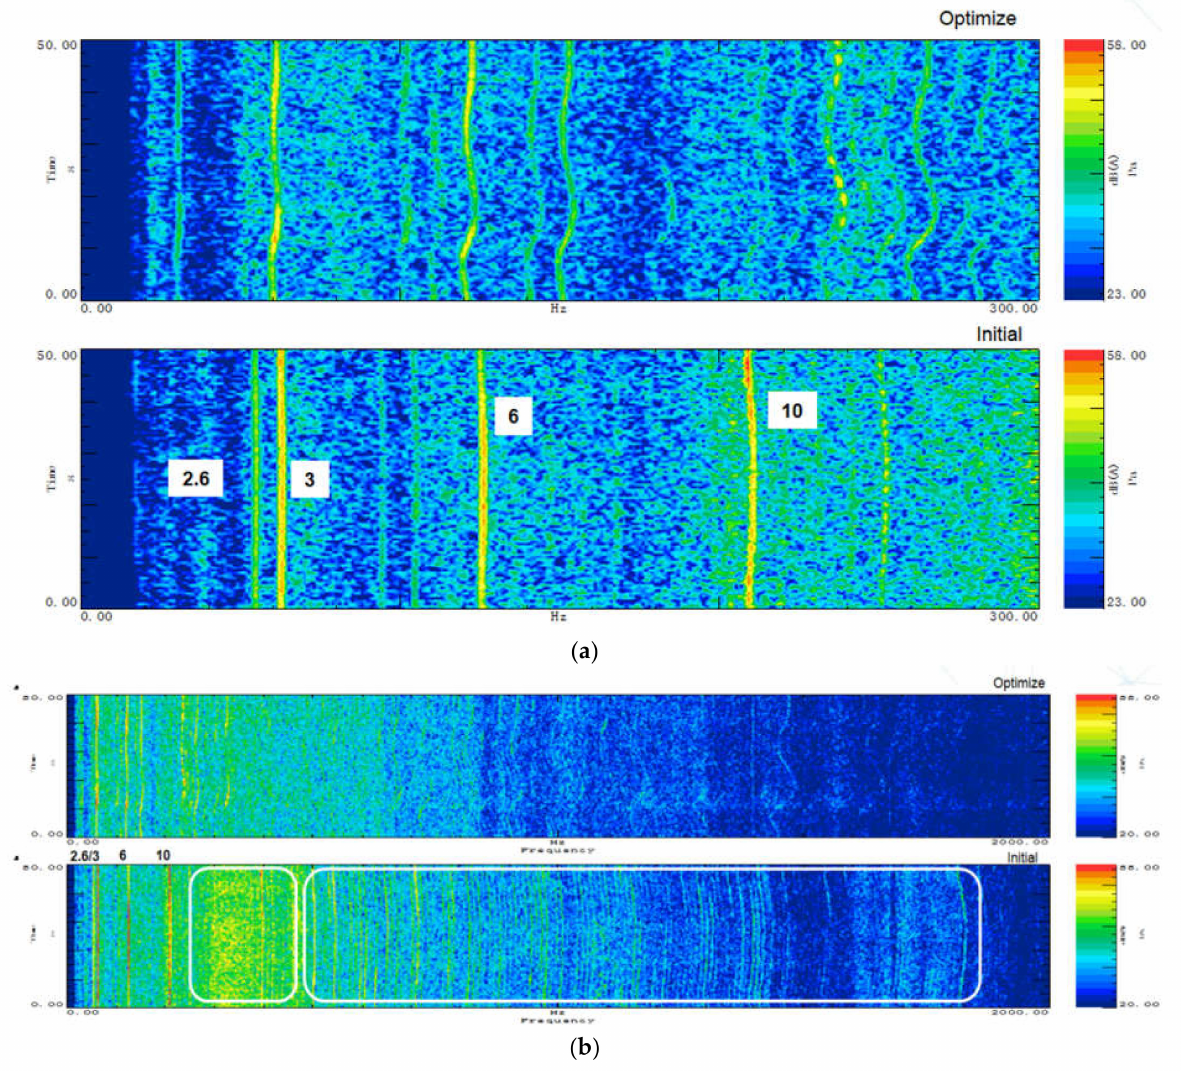
Figure 20. Noise frequency extraction at different speeds. ( a ) Spectrum extraction of driver’s ear noise (80 km/h); ( b ) Spectrum extraction of driver’s ear noise (70